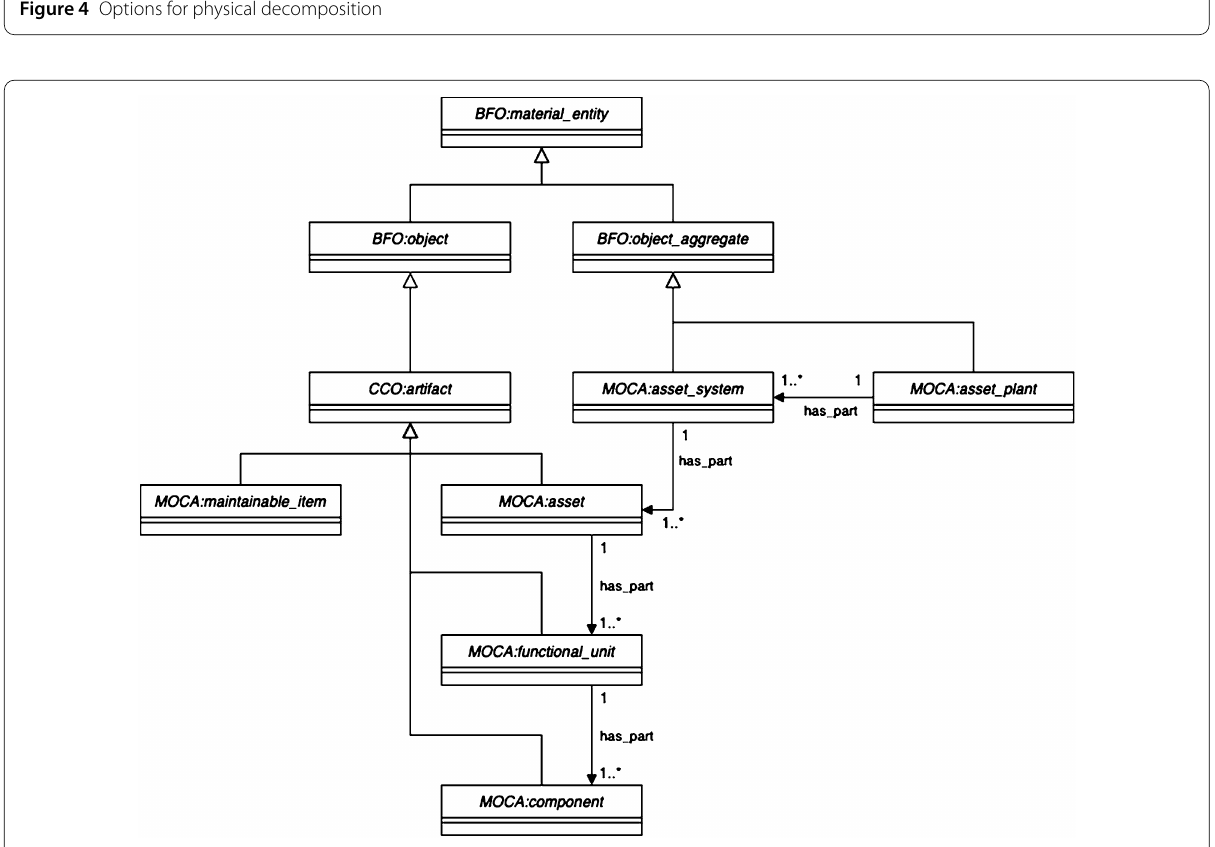
Figure 5 Physical decomposition in